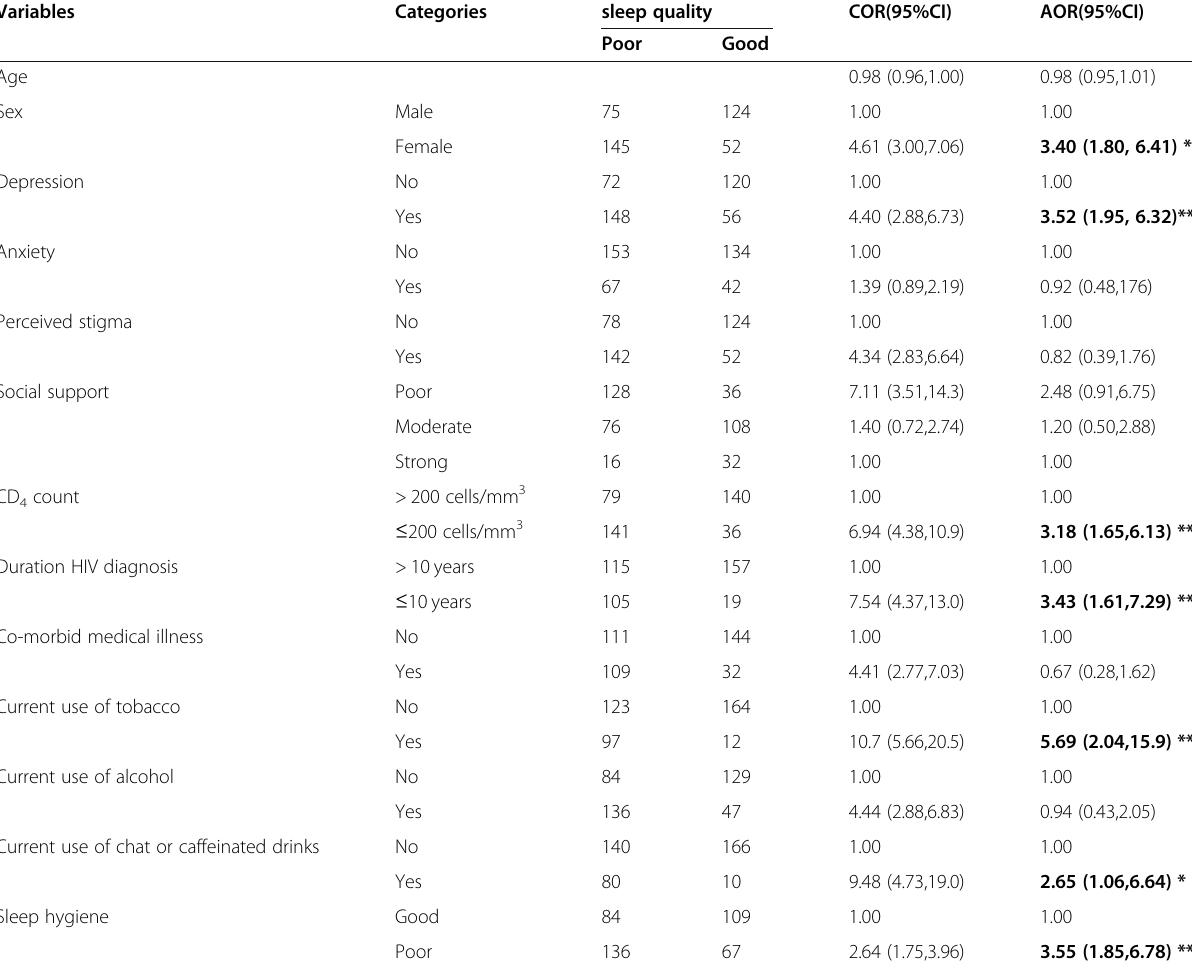
Table 3 Factors associated with poor sleep quality among people living with HIV/AIDS at Zewditu Memorial Hospital (Bivariate and multivariate analysis) (n = 396), Addis Ababa, Ethiopia,